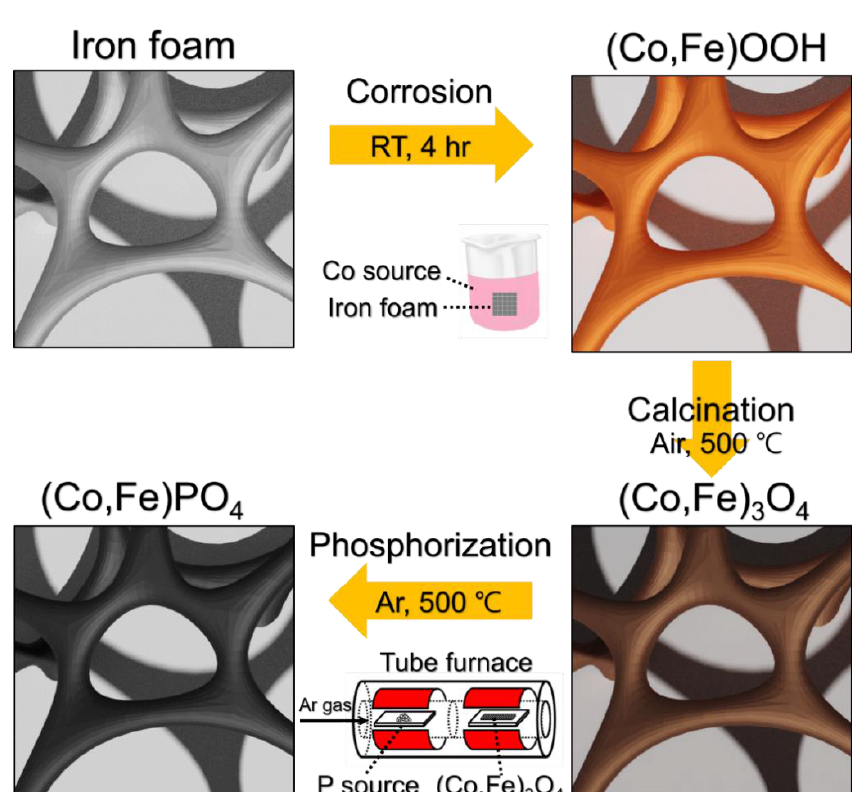
Figure 1. Schematic for synthesizing (Co,Fe)PO 4 on the iron foam. To determine the crystalline structures of the synthesized (Co,Fe)OOH, (Co,Fe) 3 O 4 , and (Co,Fe)PO 4 electrocatalysts, the XRD patterns were obtained (Figure S1). The diffrac- tion peaks of the (Co,Fe)OOH sample appeared at 2 θ = 27.0 ◦ , 36.4 ◦ , 46.9 ◦ , 60.8 ◦ , and 79.6 ◦ , and were indexed to the (021), (130), (150), (132), and (202) planes, respectively, of iron oxy- hydroxide (FeOOH, JCPDS # 01-073-2326). The diffraction peaks of the (Co,Fe) 3 O 4 sample that appeared at 2 θ = 18.3 ◦ , 30.1 ◦ , 35.5 ◦ , 37.1 ◦ , 43.1 ◦ , 57.0 ◦ , and 62.6 ◦ were indexed to the (111), (220), (311), (222), (400), (511), and (440) planes, respectively, of iron oxide (Fe 3 O 4 , JCPDS # 01-075-0033). However, for the (Co,Fe)PO 4 sample, both the iron phosphate and iron oxide phases were discerned, corresponding to FePO 4 (JCPDS # 00-029-0715) and Fe 3 O 4 (JCPDS # 01-075-0033). This result indicated the hybrid structure of (Co,Fe) 3 O 4 and (Co,Fe)PO 4 . The peaks of Fe 3 O 4 exhibited almost identical diffraction peaks with the (Co,Fe) 3 O 4 sample, and the peaks from the (100) and (102) planes of FePO 4 were observed at 20.3° and 25.8°, respectively. Generally, chemical transformation reactions, such as sulfurization, phosphidation, and selenization, also occurred at the surface. [45 – 47] Therefore, after phosphidation, the outer region of (Co,Fe) 3 O 4 was converted into (Co,Fe)PO 4 , and the inner region of (Co,Fe) 3 O 4 did not participate in the chemical trans- formation reaction. [48,49].